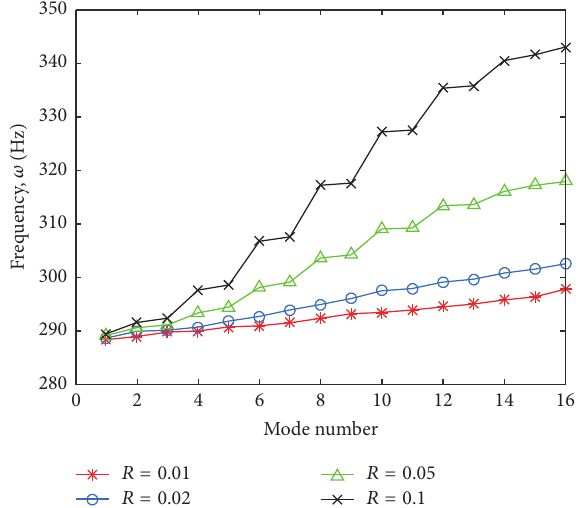
Figure 8: Natural frequencies of MRBs under different 𝑅